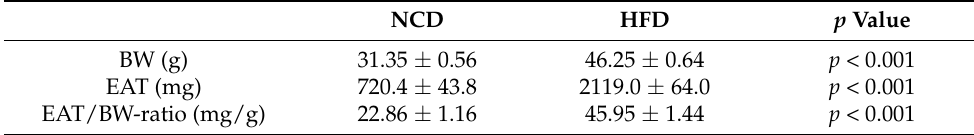
Table 1. Effect of dietary treatment on body weight and